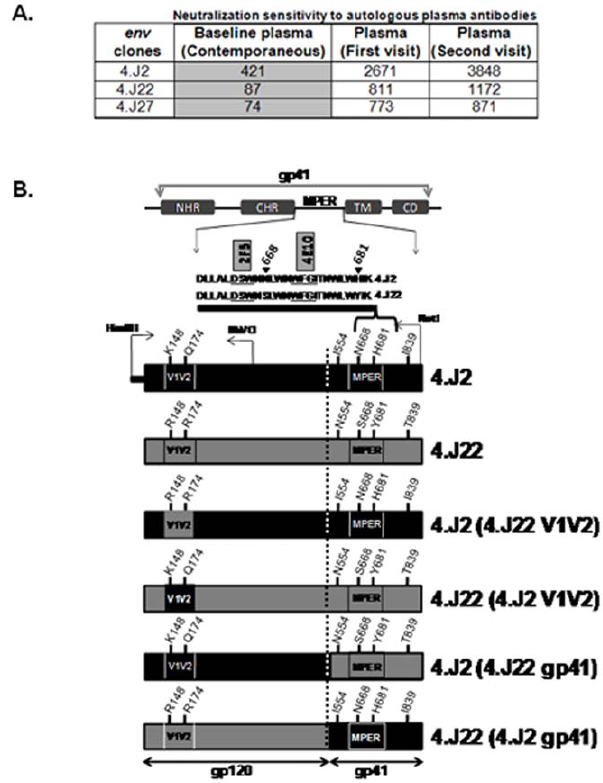
Figure 1. Construction of chimeric envelopes. Chimeric Envs were constructed by swapping of gp120 and gp41 between sensitive (4.J2) and resistant (4.J22) patient Envs using NotI, BbvCI and HindIII restriction enzymes. The ID50 values of pseudotyped viruses carrying 4.J2, 4.J22 and 4.J27 Envs to autologous plasma reported earlier [46] were shown on top; highlighted column represents ID50 of Env- pseudotyped viruses to contemporaneous plasma at the base line.